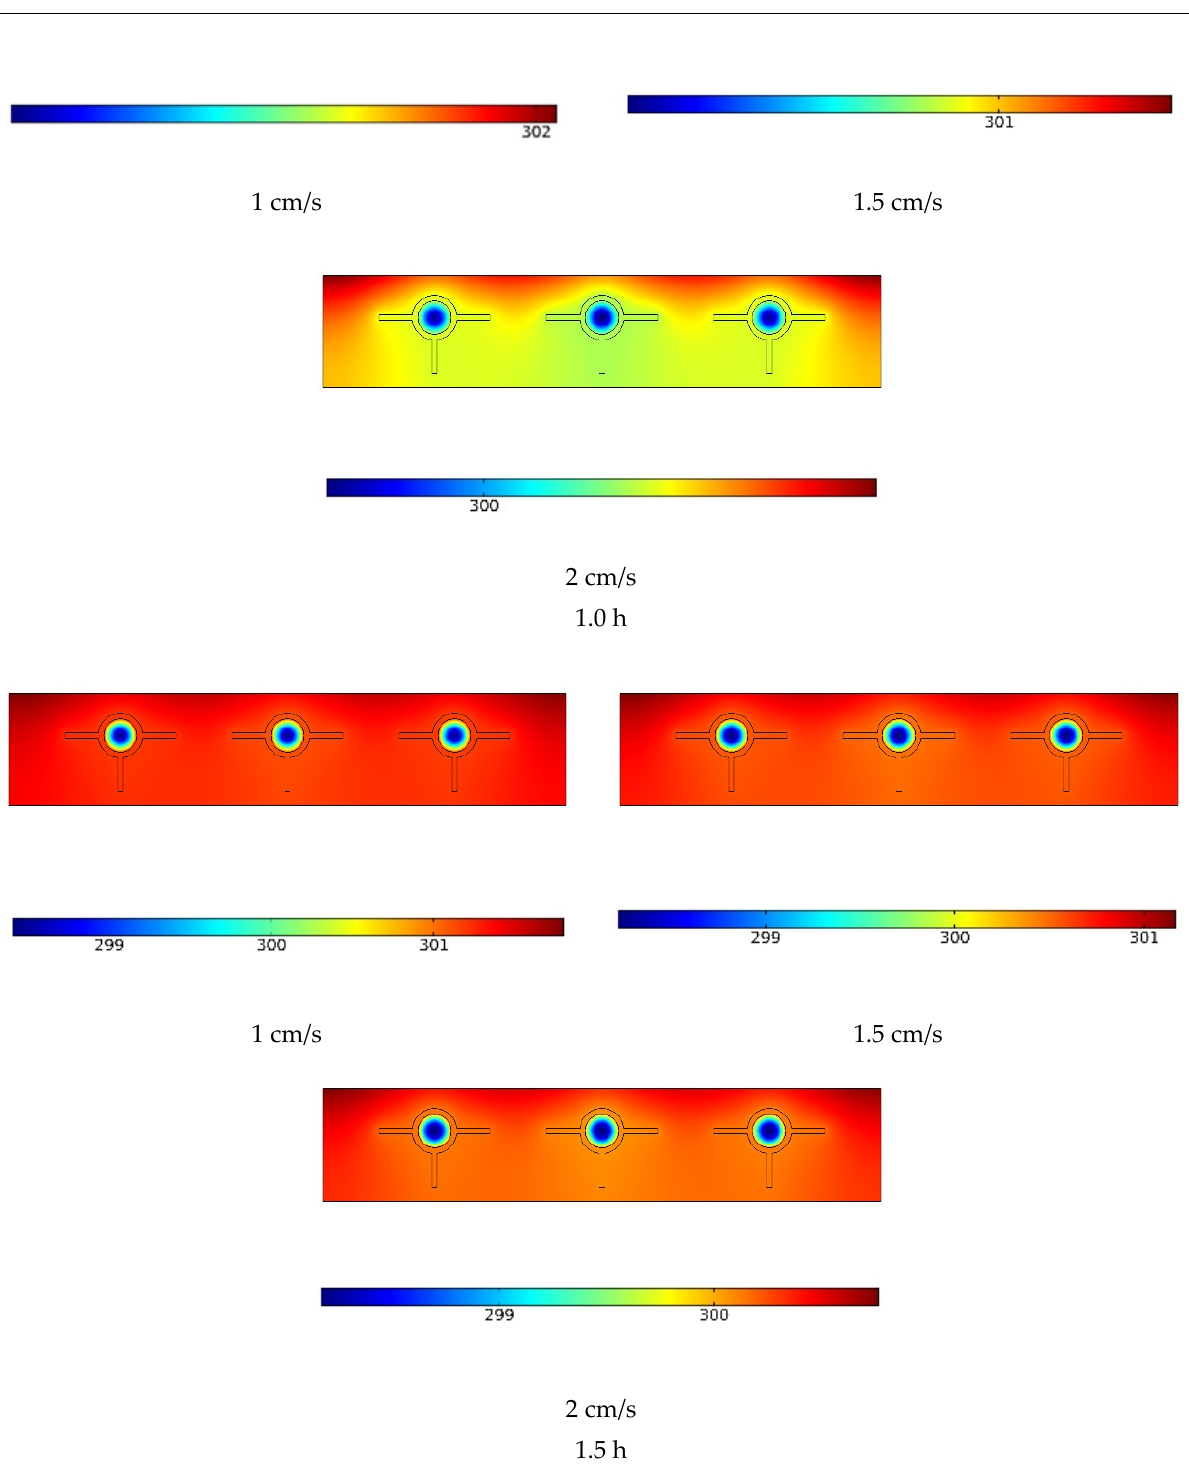
Figure 3. The temperature contour in the vertical middle section of the solar panel at three velocities and three times.